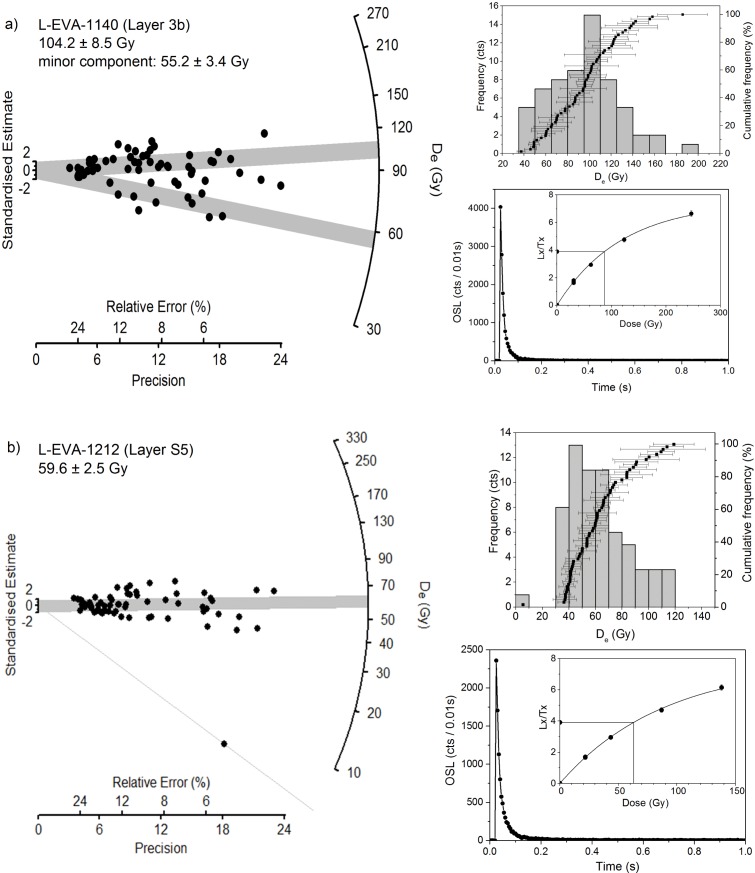
Representative OSL characteristics for two sediment samples from Rhafas.Radial plots and frequency histograms show the dose distributions of single grains, and a natural OSL decay curve with dose response curve (as inset) for samples (a) L-EVA-1140 and (b) L-EVA-1212, respectively. The shaded bands in the radial plots correspond to the standard error deviation from the calculated De.